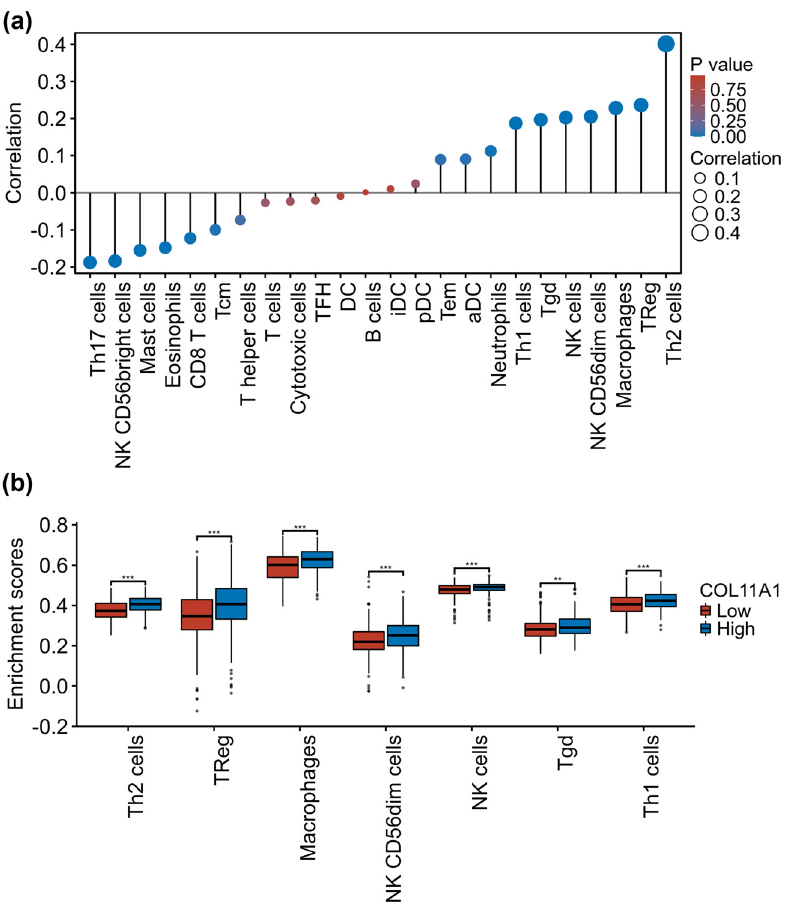
Figure 5: COL11A1 correlates with immune in fi ltration in LUAD. ssGSEA algorithm was used to evaluate the correlation between COL11A1 and immune cell enrichment in LUAD ( a ) . The enrichment score of seven immune cells, including Th2 cells, TReg, macrophages, NK CD56dim cells, NK cells, Tgd and Th1 cells, was evaluated between COL11A1 high expression group and low expression group ( b )